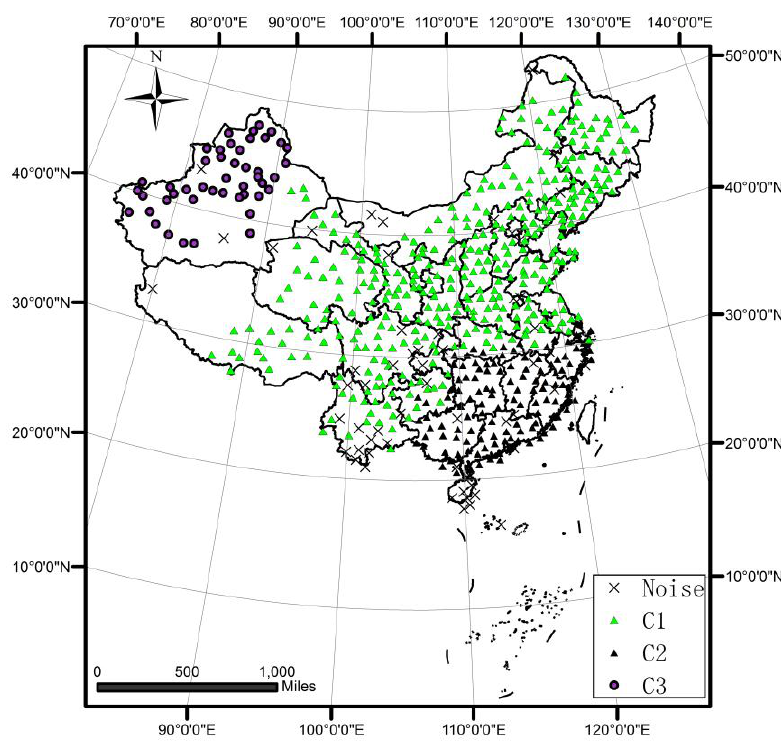
Figure 20. Clustering result of rainfall data using density-based time series clustering algorithm.